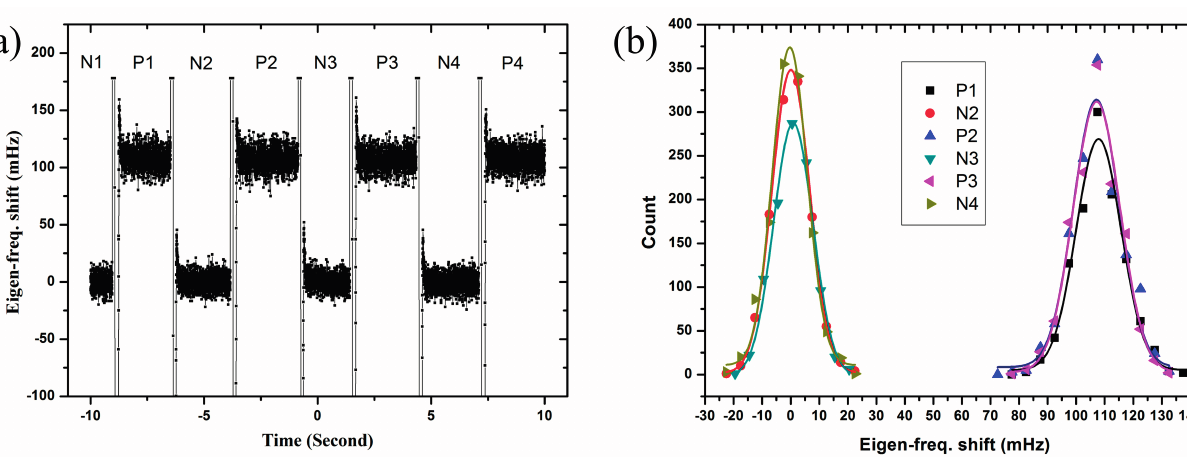
Figure 3. ( a ) The plot of the eigen-frequency change as the bias voltage was switched between 0 V and +130 V for the anti-phase QTF. The results of the in-phase and qPlus QTFs were very similar and they are omitted here; ( b ) Gaussian distributions fitted to the data. The bias voltages at 0 V and +130 V are labelled N and P, respectively.